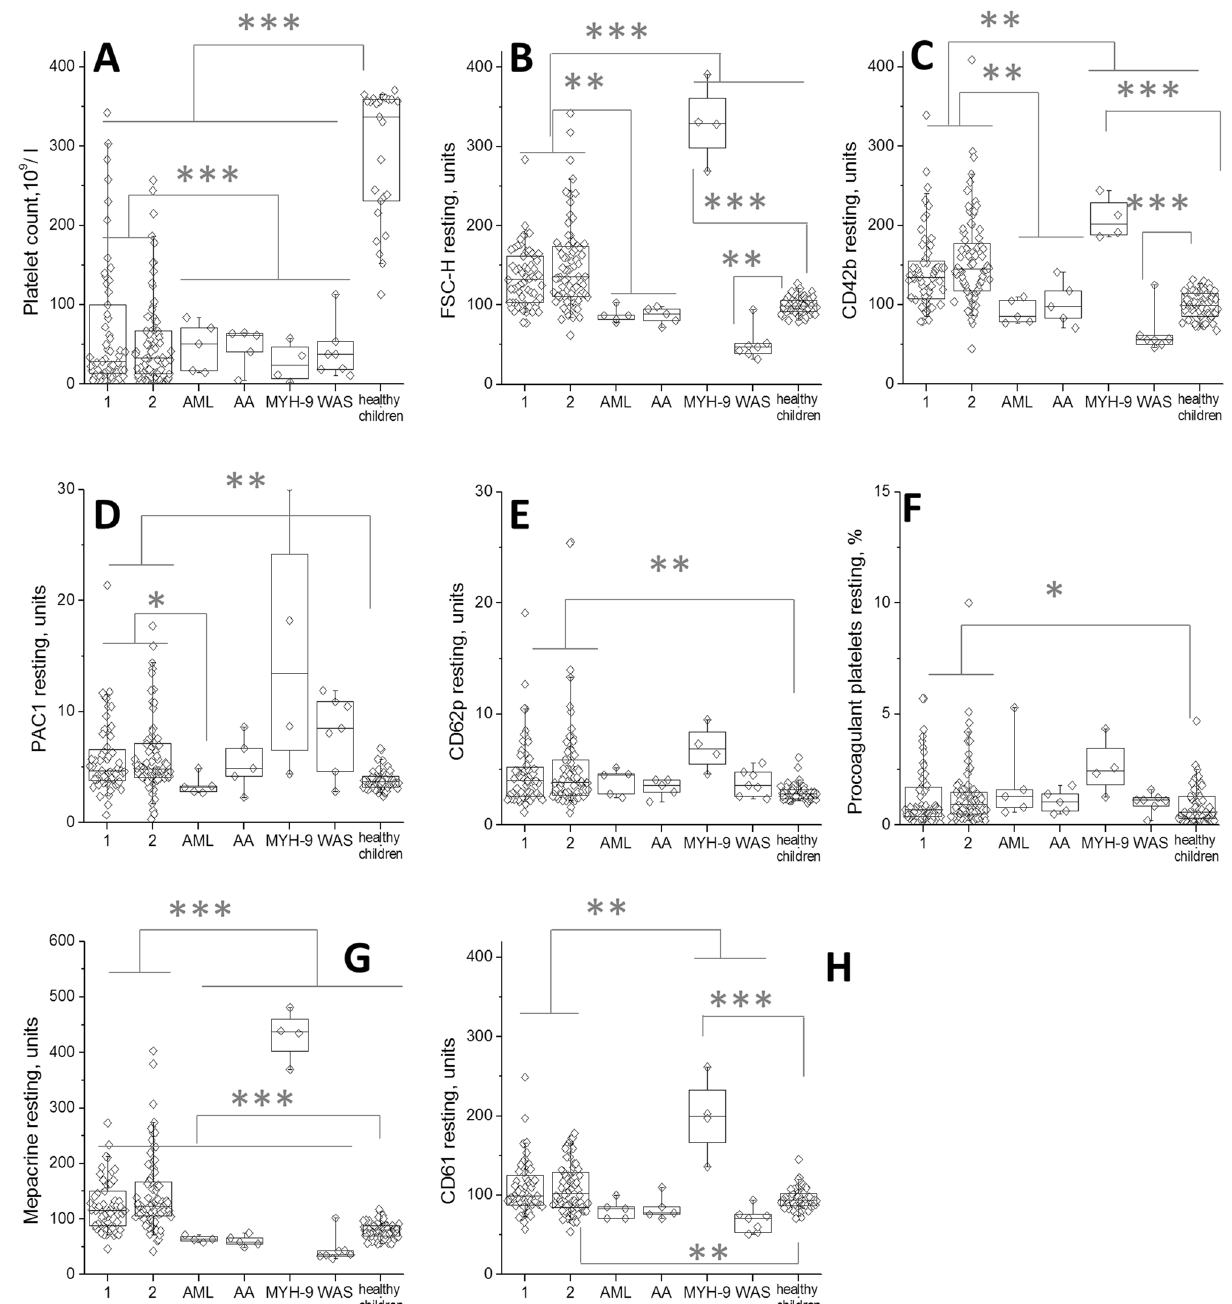
Figure 3. Platelet function in non-ITP thrombocytopenias. The panels show platelet function parameters for acute/persistent ITP (< 1 year, labeled as 1); chronic ITP (> 1 year, labeled as 2); leukemia (AML and JMML); aplastic anemia (AA); MYH-9 associated macrothrombocytopenia (MYH-9); Wiskott-Aldrich syndrome (WAS); and healthy donors. Statistics is as in Fig. (except for ITP patients without bleeding, Fig. S11D,E, respectively), but not upon stimulation by 10 µM of TRAP-6 (Fig. S11F), correlated with resting CD62p. Finally, no correlation was observed between resting cyto- solic calcium, calcium after stimulation by 2 µM of ADP and amount of procoagulant platelets after stimulation (Fig. S11G,H, correspondingly), while calcium in TRAP-6 activated platelets correlated with the amount of pro- coagulant platelets (Fig. S11I). Platelets of the patients with chronic ITP had increased calcium independently of romiplostim treatment (Fig. 4D). Resting calcium was increased in both chronic and acute/persistent ITP (Fig. 4D). Thus, increased basal cytosolic calcium levels in platelets of ITP patients could be associated with the pre-activation, determined by resting CD62p binding.